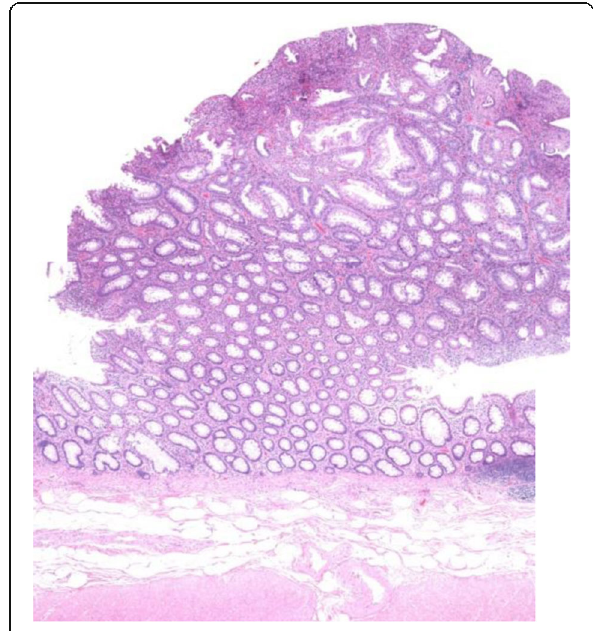
Fig. 4 Histopathological findings were mild adenomatous glands with mixed inflammatory infiltration. The polyp was covered with inflammatory granulation tissue, a ‘ cap. ’ (× 40 magnification, Hematoxylin Eosin staining)